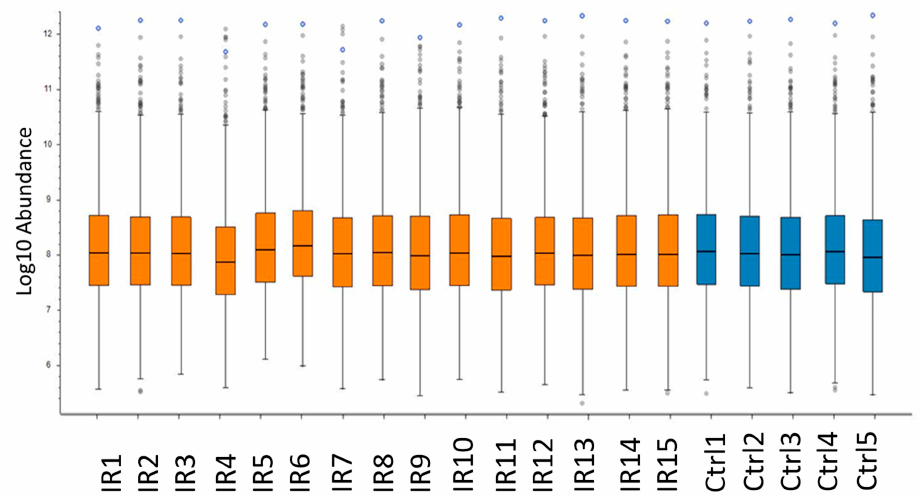
Figure 3. Comparison of protein abundance between heart samples. The box-and-whisker plot shows the abundance of the not-normalized intensity values for each individual of irradiated (IR) and control (Ctrl) groups. The analysis was performed using the Proteome Discoverer 2.3 software (Thermo Scientific, Waltham, MA, USA). Detailed information of the sample donors and the exact doses are given in Table S4.